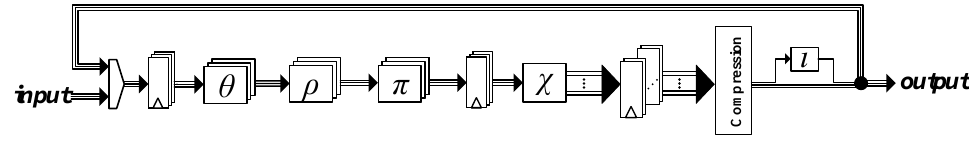
Figure 1: Design architecture of our round-based second-order Keccak .